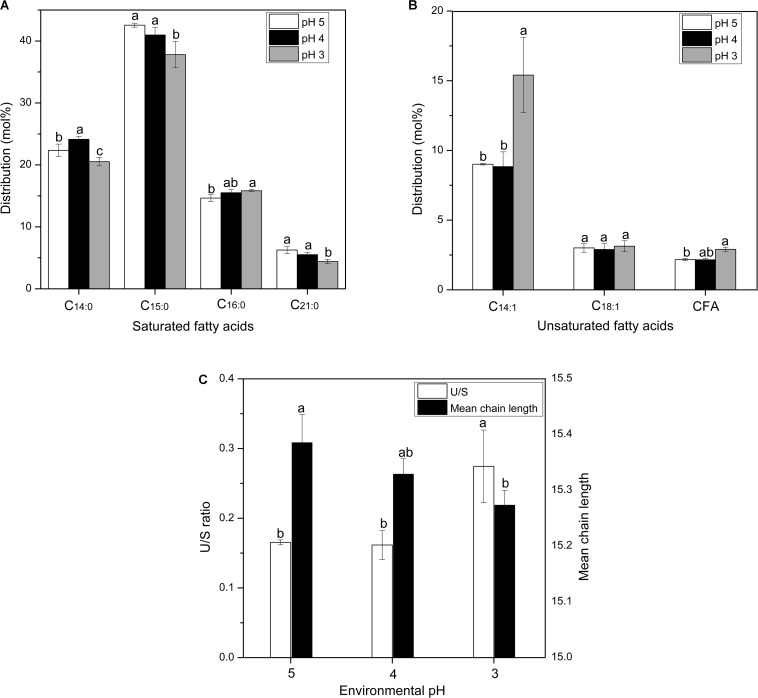
Changes in the distributions of membrane saturated fatty acid (A) and unsaturated fatty acid (B), U/S ratio and mean chain length (C) of S. albulus M-Z18 in batch fermentations at different environmental pH (pH 5.0, 4.0, and 3.0). Samples were collected at 27 h. Statistical significance is denoted by different letter for the same indicator.